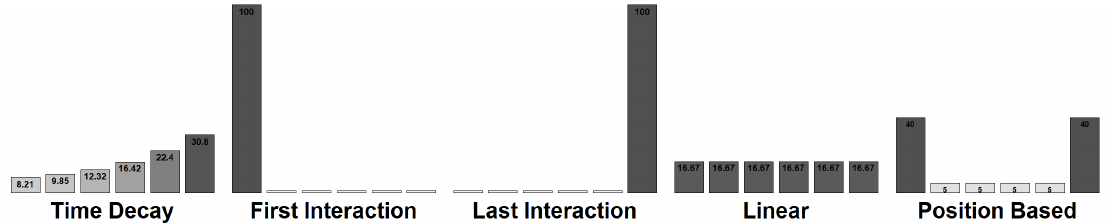
Figure 1. Touchpoint distribution based on the position for all of the first-generation models. Where on the left is the first touchpoint in the path and the rightmost bar is the last